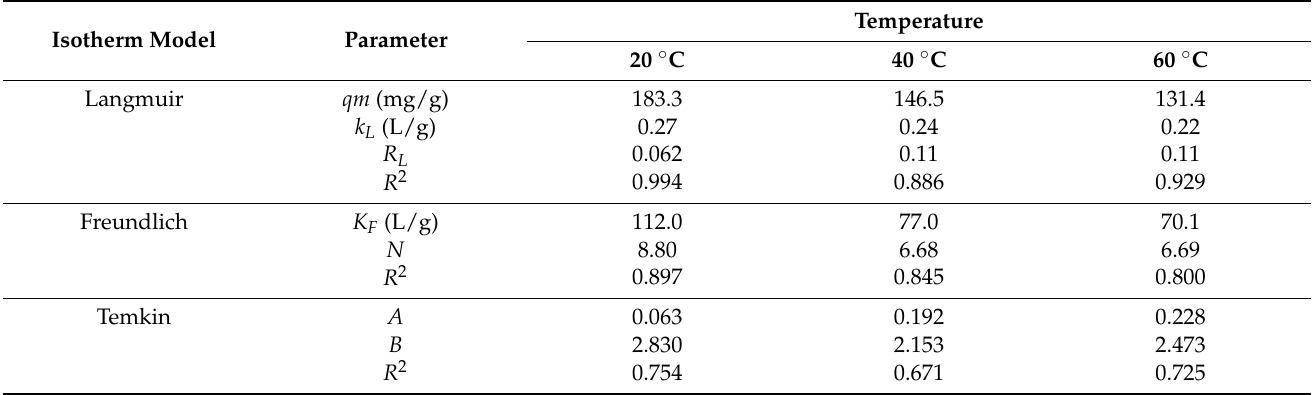
Table 1. Demonstrates the parameters of the isotherm model for the MB adsorption at vari- ous